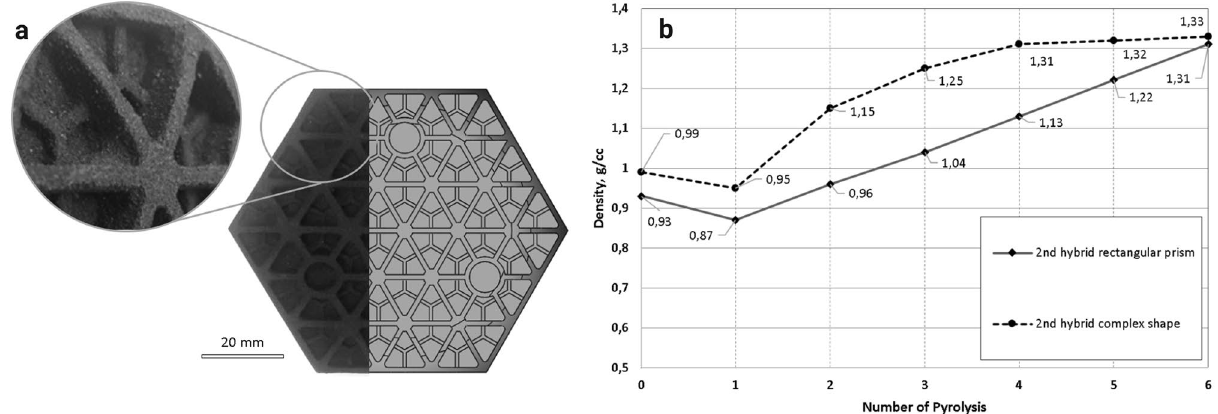
Figure 9. ( a ) Overview of graphite BJP complex structures densified through PRBI and pyrolysis cycles; ( b ) dependence of the hybrid complex-shape sample’s density on the number of pyrolysis. The 2nd up to 6th pyrolysis was applied after